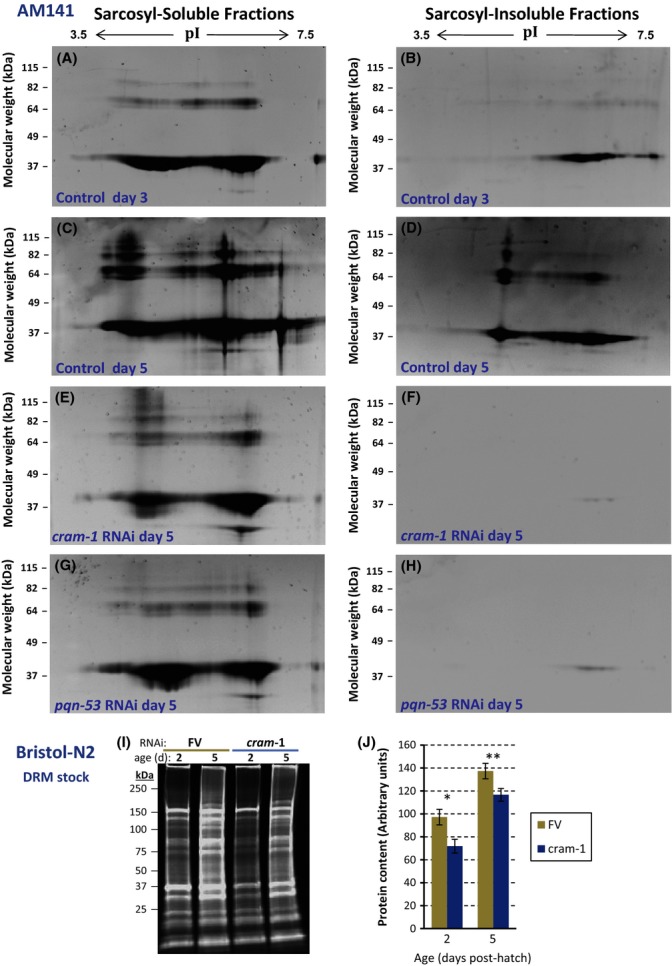
Aggregated proteins from Caenorhabditis elegans adults expressing Q40::YFP in muscle. (A–H): center areas of 2D gels, stained with SYPRO Ruby, resolving proteins from aggregates pulled down with antibody to GFP. Worms were grown from hatch on ‘FV’ bacteria without RNAi (A–D) or expressing dsRNA targeting cram-1 (E, F) or pqn-53 (G, H). Aggregates, isolated from strain AM141 at 3 dPH (A, B) or 5 dPH (C–H), were partitioned into those soluble (A, C, E, G) or insoluble (B, D, F, H) in 1% sarcosyl. Lanes contain equal worm equivalents of aggregated proteins, dissolved in Laemmli buffer at 95 °C. Material at ∼40 kDa binds antibody to GFP and thus may comprise modified/degraded fragments of Q40::YFP. Sarcosyl-soluble and sarcosyl-insoluble aggregate proteins from wild-type/Bristol-N2 at 2 dPH (L4 larvae) or 5 dPH (adults) were resolved by 1D electrophoresis (I) and quantified (J). *Two-tailed t-test P < 0.003; **P < 0.0003.